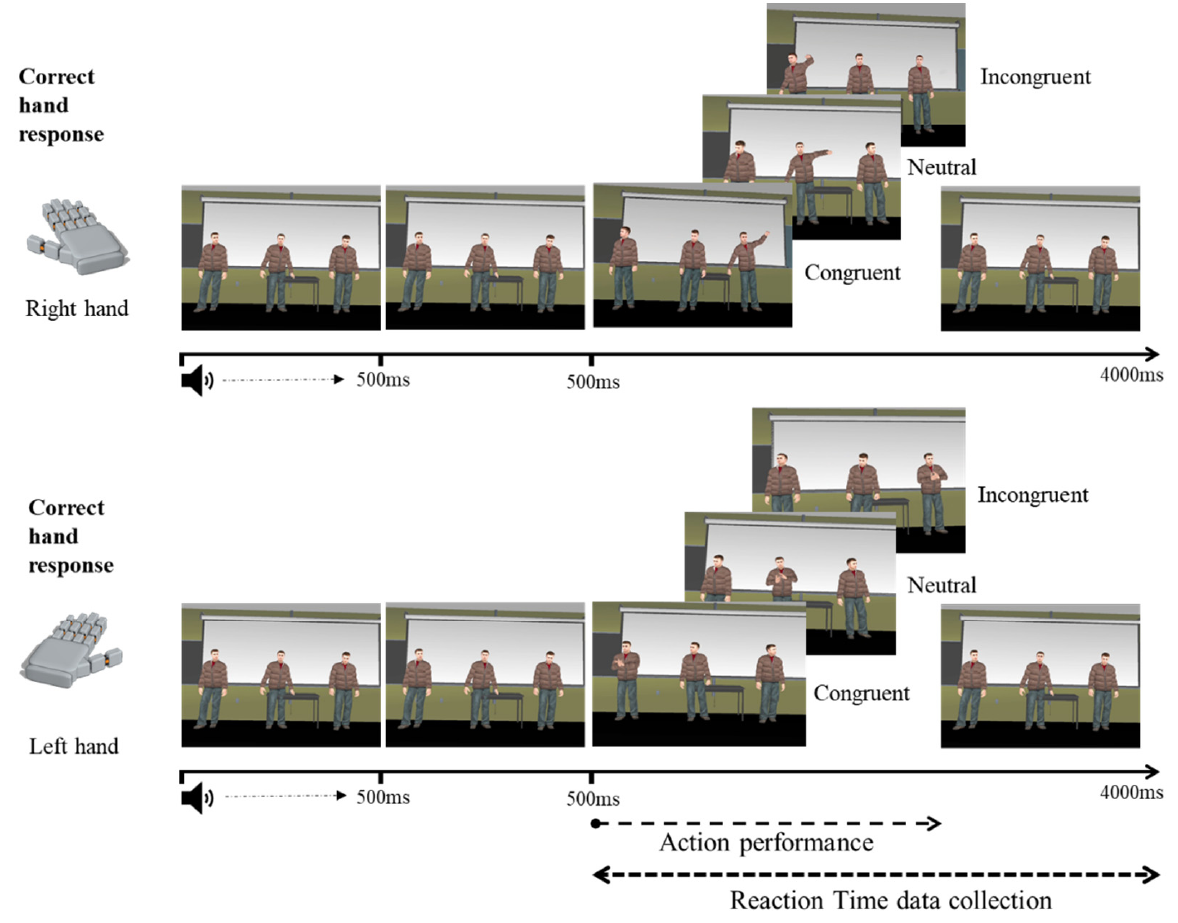
Figure 2. Time course of the 3D stimulus presentation in the VR adaptation of the Simon task. Within the virtual environment, each controller became a virtual hand; thus, partic- ipants held each virtual hand with the corresponding real hand and were asked to give quick and accurate responses by pulling the trigger in each controller to indicate if the avatar performing a movement was either clapping (left trigger) or raising a hand (right trigger). Similar to the 2D version of the task, all trials pertained to one out of three critical experimental conditions (congruent, incongruent, and neutral). Trials were defined as congruent when the moving avatars’ action was performed on the same side as the correct response trigger (e.g., leftmost avatar clapping). Similarly, incongruent trials were defined as those in which the critical avatar’s location and the correct response trigger were on opposite sides (e.g., the rightmost avatar clapping). Finally, when the moving avatar was centred on the participants’ point of view, these trials were defined as